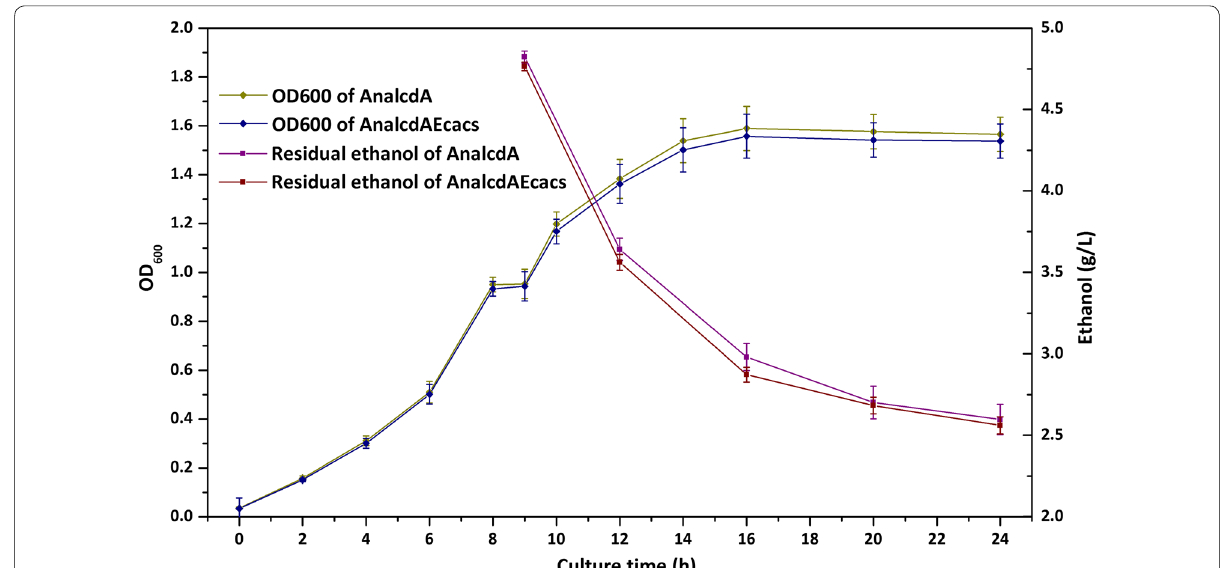
Fig. 4 Effects of acetyl-CoA synthetase on ethanol utilization. AnalcdA, E. coli BL21(DE3) harboring pTrc-AnalcdA; AnalcdAEcacs, E. coli BL21(DE3) harboring pTrc-AnalcdA and